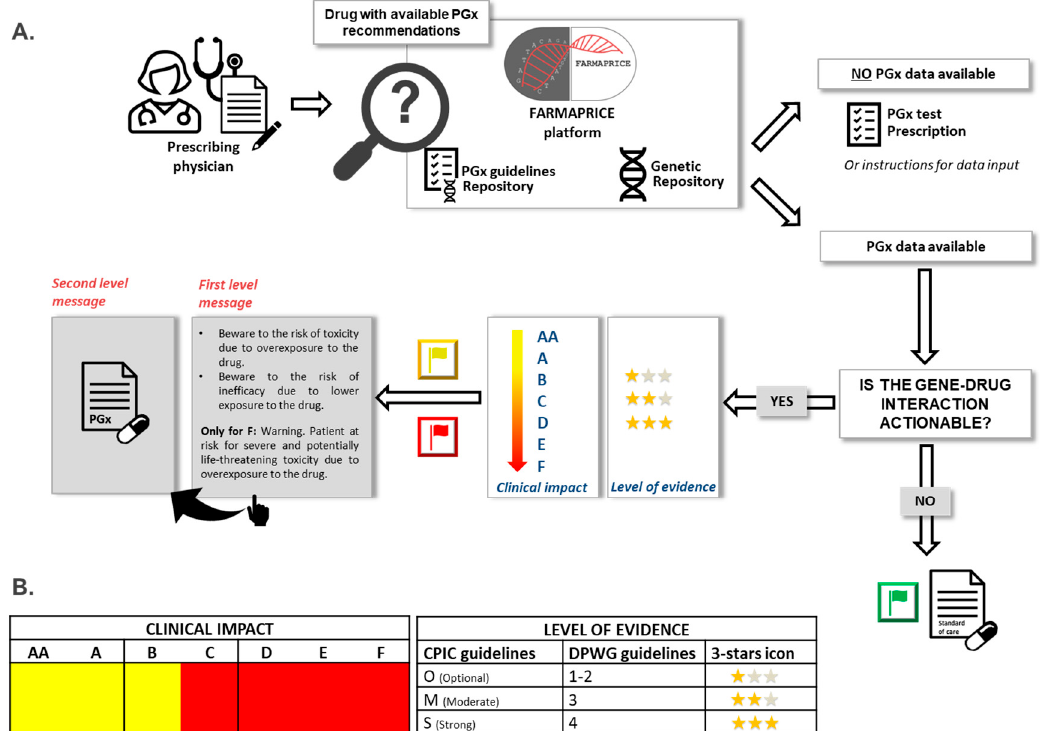
Figure 1. FARMAPRICE platform workflow. ( A ) The prescribing physician interrogates FARMAPRICE platform to discover if the drug to be prescribed presents validated gene-drug interactions and if that specificpatienthasapotentiallyclinicallyactionablegenotype. Inthenegativecaseinstructionsaregiven for a pharmacogenetic (PGx) test prescription. In the a ffi rmative case, a PGx-based recommendation integrated with its level of evidence and clinical impact will be provided. This will allow prescribers to weigh the strength of evidence available and to decide whether to follow the recommendation or not. A PGx-based recommendation will be first delivered as a “first level message” briefly describing the involved risk (ine ffi cacy or toxicity) for that specific patient at standard dosage. A “second level message” (complete PGx-based drug selection or dosing recommendation) is displayed by clicking on “first level message”. ( B ) Clinical impact of a specific gene-drug interaction is delivered with a di ff erent colors flag icon basing on Swen et al. [13]. Correspondence between rating from AA to F and the color code is here defined. Conversely, the level of evidence will be delivered as a three-star icon basing on both Clinical Pharmacogenetics Implementation Consortium (CPIC) and Royal Dutch Association for the Advancement of Pharmacy—Pharmacogenetics Working Group (DPWG) latest guidelines available for that gene-drug interaction as herein